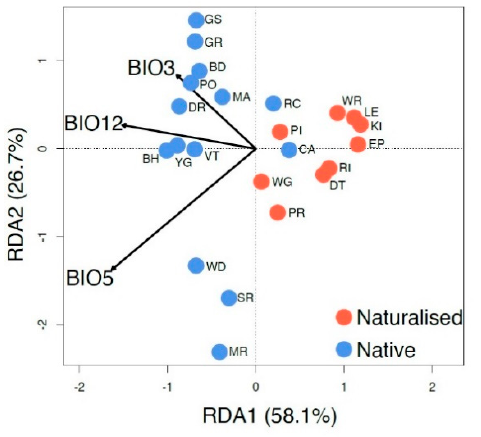
Figure 4. STRUCTURE analysis identified an optimal value of K = 4 when only all native (WA) samples Figure 5. Redundancy analysis with the mean annual precipitation (BIO12), maximum temperature were included. of the warmest month (BIO5), and isothermality (BIO3). Individuals are labeled with their population (as in Table 1). Arrow length indicates the magnitude of variation explained (r 2 ) for each climate variable (BIO12, p = 0.017, r 2 = 0.61; BIO5, p = 0.001, r 2 = 0.32; BIO3, p = 0.097, r 2 = 0.20).